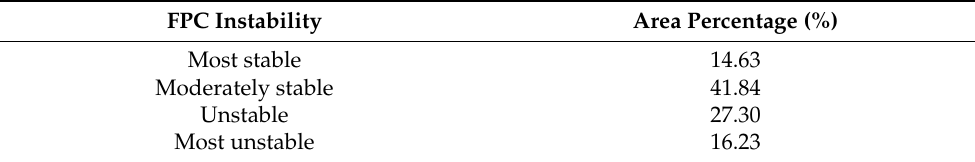
Table 5. Area statistics corresponding to FPC instability.